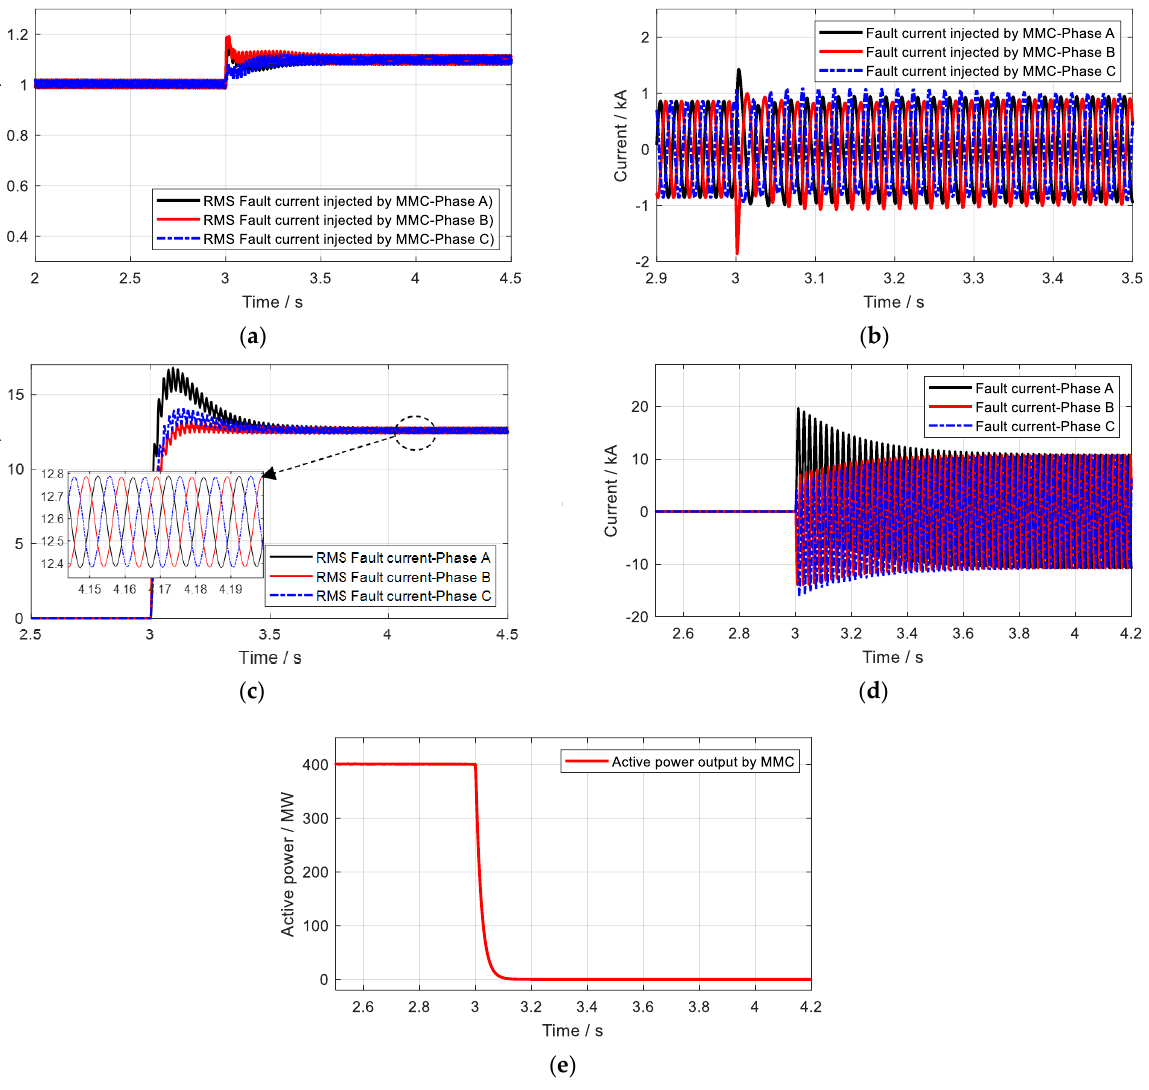
Figure 12. The simulation situations in case 2. ( a ) The RMS short-circuit current injected by the MMC after the fault. ( b ) The instantaneous short-circuit current injected by the MMC after the fault. ( c ) The RMS short-circuit current of the whole system after the fault. ( d ) The instantaneous short-circuit current of the whole system after the fault. ( e ) The active power transmitted by the MMC.